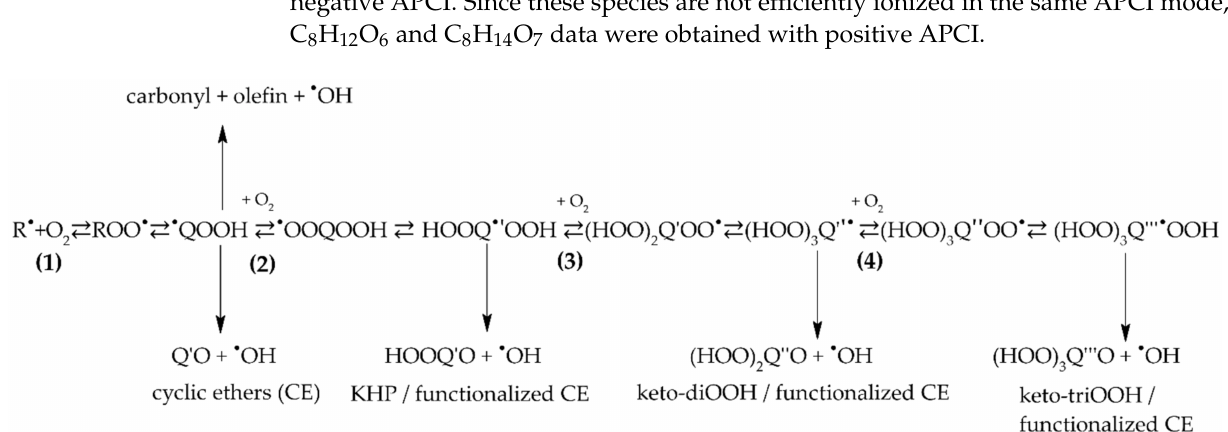
Scheme 5. Schematic representation of the low-temperature oxidation pathways including the formation of KHPs, di and tri-hydroperoxides, and functionalized cyclic ethers isomers. (1) to (4) refer to first to fourth O 2 addition.